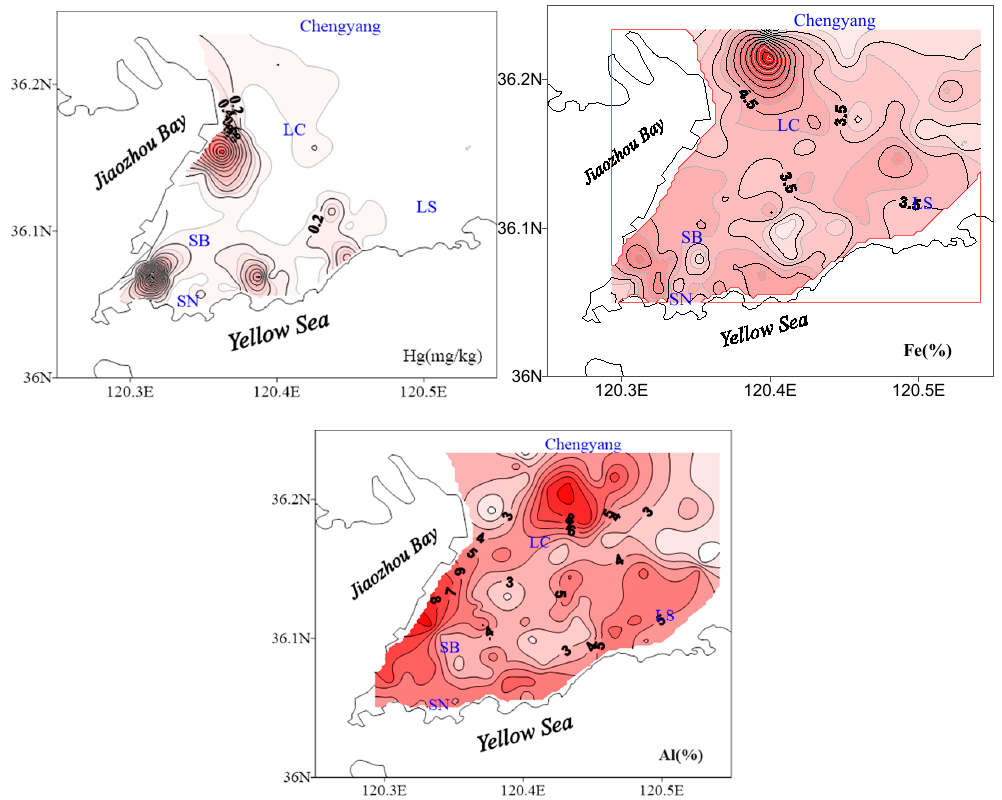
Figure 2. Spatial distribution maps of heavy metals from settled dust in Qingdao.